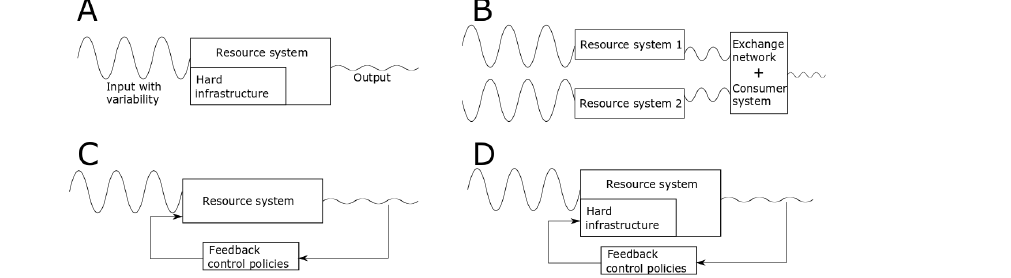
Fig. 1 . A typology of robustness-fragility trade-off (RFTO). (A) Structural RFTO represents a direct modification to a resource system structure, e.g., the construction of levees, dams, or irrigation canals, to reduce variability in a system output, e.g., water availability, flood risk, etc. (B) Network RFTO: two “source” resource systems whose outputs or benefit flows do not co-vary under a disturbance and a “sink” consumer system are connected through an exchange network. This exchange network reduces variability in the combined benefit flows to the sink system. (C) Feedback RFTO represents an insertion of feedback responses, e.g., control actions guided by pre-existing policies, to variations in a system state to achieve stability. (D) Structural and feedback RFTO combines structural RFTO and feedback RFTO, i.e., system structure is modified, and feedback responses are generated simultaneously. Adapted from Anderies